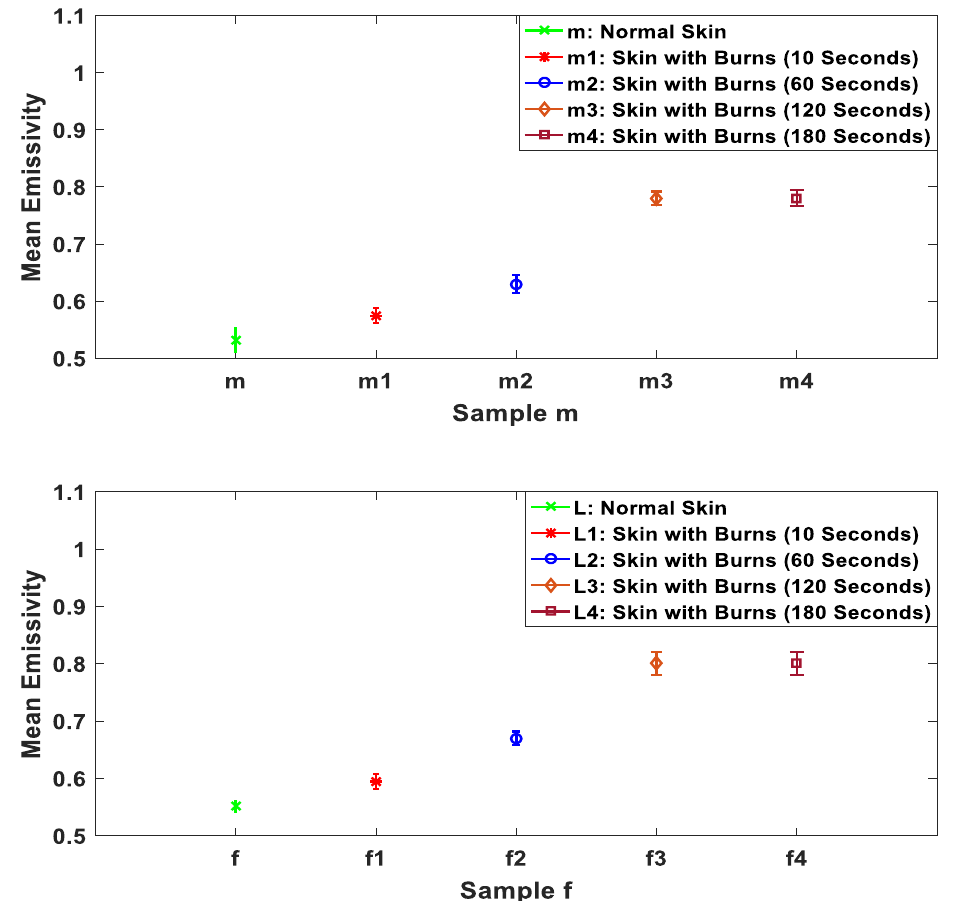
Figure 11. Mean emissivity values and standard deviation bars for porcine skin samples (obtained from different animals) before and after different applications of localized heat treatments. Samples m and f represent normal skin; m1 and f1 represent skin with burns after 10 s of localized heat treatment, m2 and f2 represent skin with burns after 60 s of extra heat treatment, m3 and f3 represent skin with burns after 120 s of extra application of heat treatment, and m4 and f4 represent skin with burns after 180 s of extra application of heat treatment.